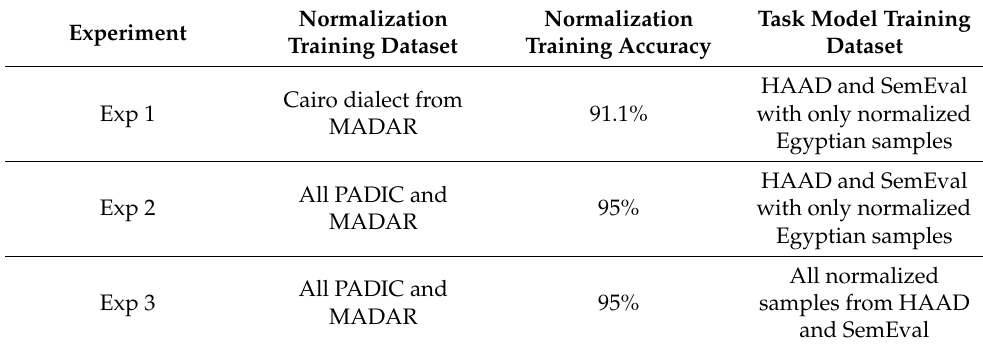
Table 6. Summary of the conducted experiments. Exp 1, Exp 2, and Exp 3 refer to the first, second, and third experiments, respectively.